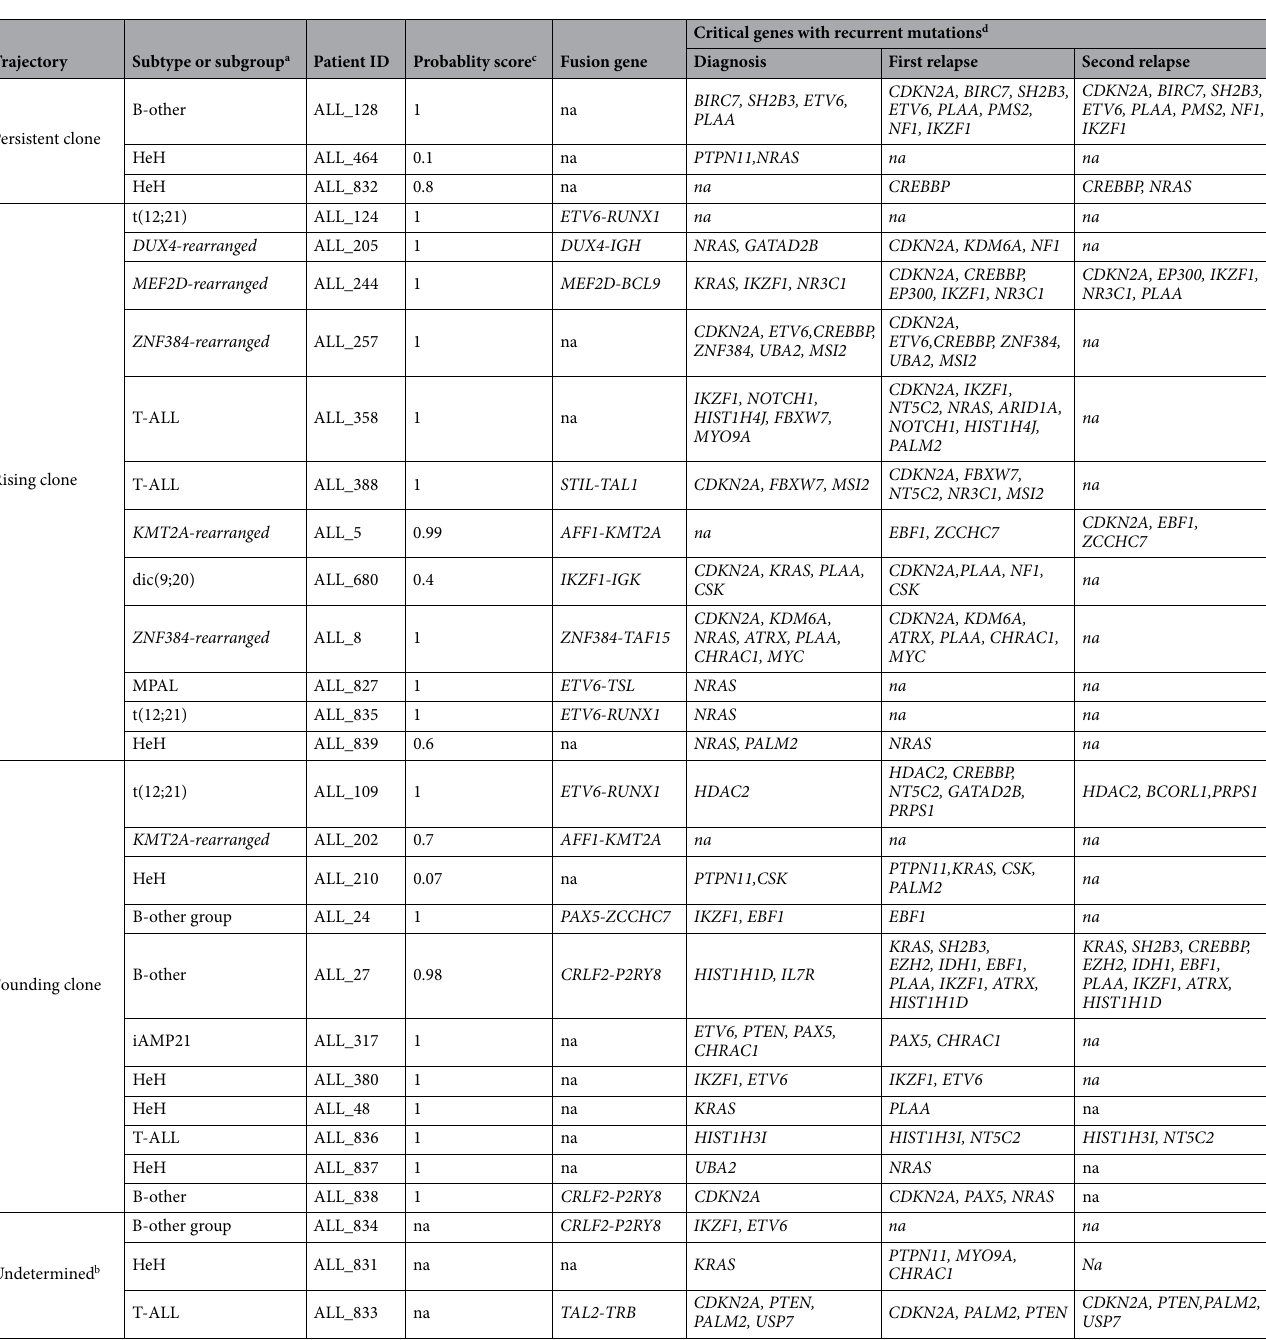
Table 2. Characteristics of clonal evolutionary trajectories for patients with acute lymphoblastic leukemia (ALL). a Genetic subtype revised based on whole genome sequencing (WGS) data; see Table 1 for more information, b Undetermined evolutionary trajectory due to either low tumor content in relapse